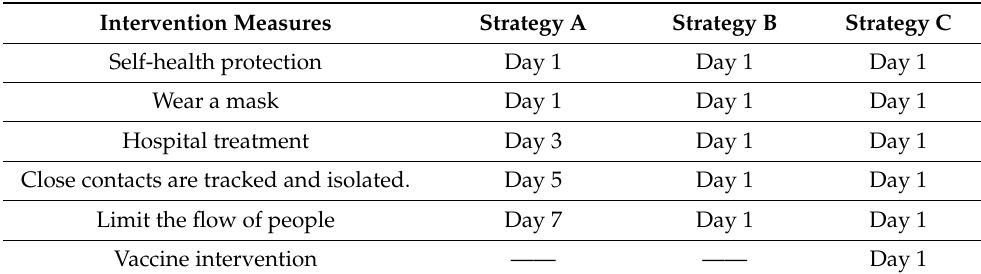
Table 6. Components of the intervention strategies. Intervention